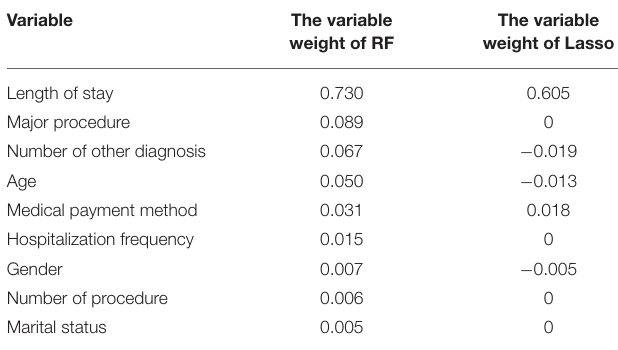
FIGURE 1 | Relationship between Lambda and MSE. TABLE 4 | Comparison of model prediction performance.